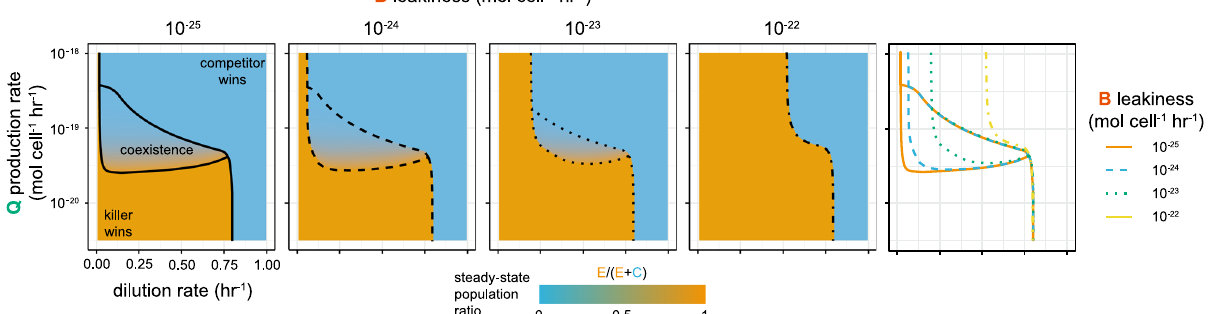
Fig. 7 Bacteriocin leakiness reduces the region of co-existence. Simulations of the parametrised mathematical model show regions in which stable co- existence is achieved. As the leakiness of the bacteriocin expression increases, the region shrinks until it eventually disappears. The gradient within the region also shows that the steady-state ratio of engineered strain to competitor strain is dependent on the quorum molecule production rate, which is controllable through arabinose